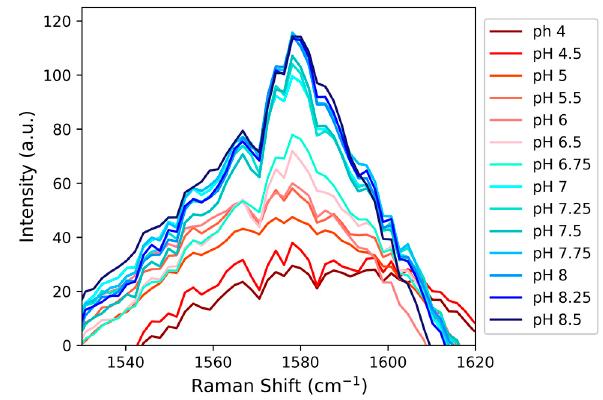
Figure 7. The growth of a peak at 1580 cm − 1 , circumstantially assigned to the C4-C5 stretch from imidazole (based on prior precedent), as a function of pH demonstrates that the signal is sensitive to changes in the protonation state of histidine.